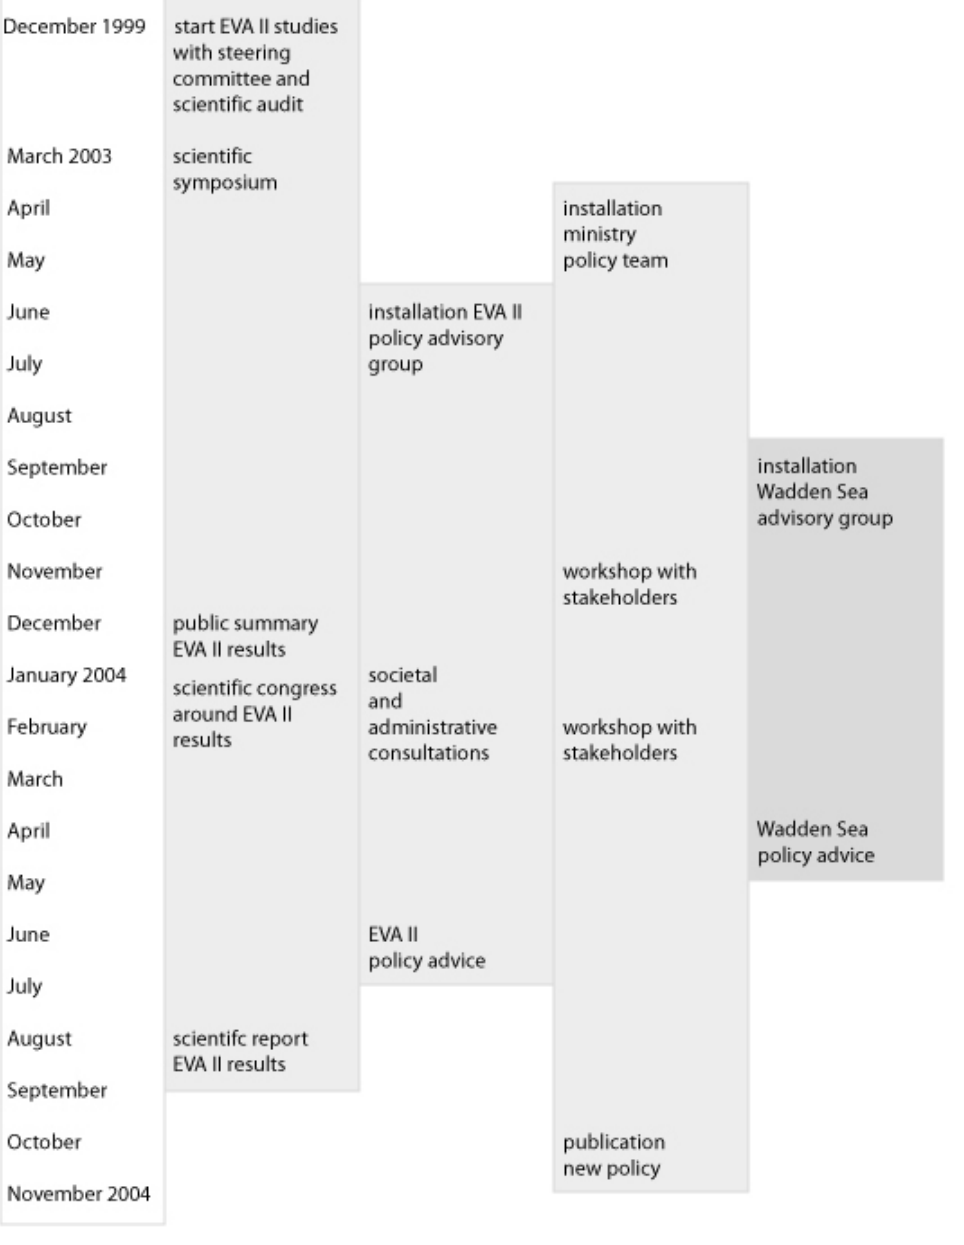
Fig. 1. Timeline of the main events and phases during the EVA II research and policy- making